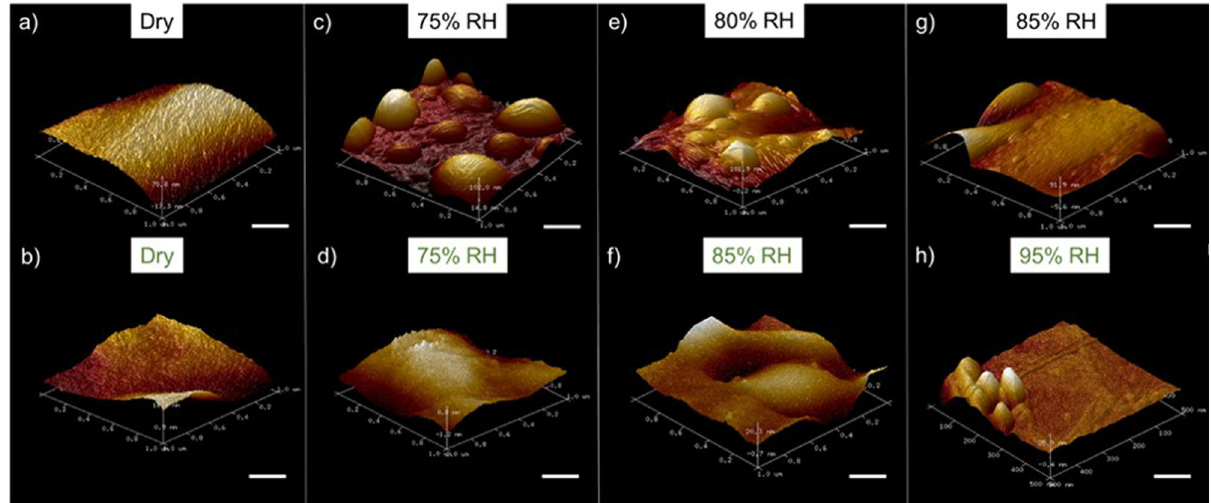
Fig. 3 Atomic force microscopy reveal humidity-induced morphological changes at the fi ber surface. Representative AFM images of the NT2RepCT (title in black) and NT2Rep Y-F CT fi bers (title in green) in the a , b dry state, c , d after being supercontracted at 75% relative humidity (RH), e , f after being supercontracted at 80% relative humidity. g Representative AFM topological image of the NT2Rep Y-F CT fi bers contracted at 85% relative humidity and h NT2Rep Y-F CT fi bers contracted at 95% relative humidity. Scale bars is 100 nm. Black color is used for NT2RepCT fi bers and green color for NT2Rep Y-F CT fi bers.